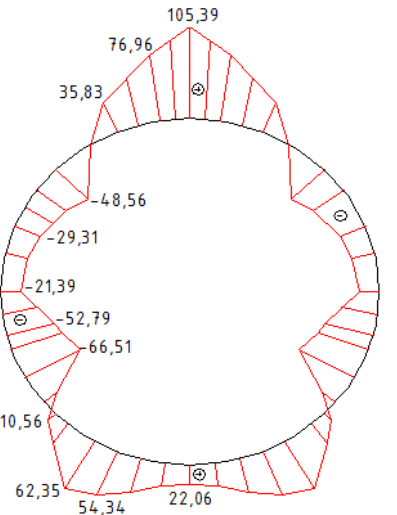
Figure 12. Stress diagram for sand backfill ( σ 105 . 39 MPa)